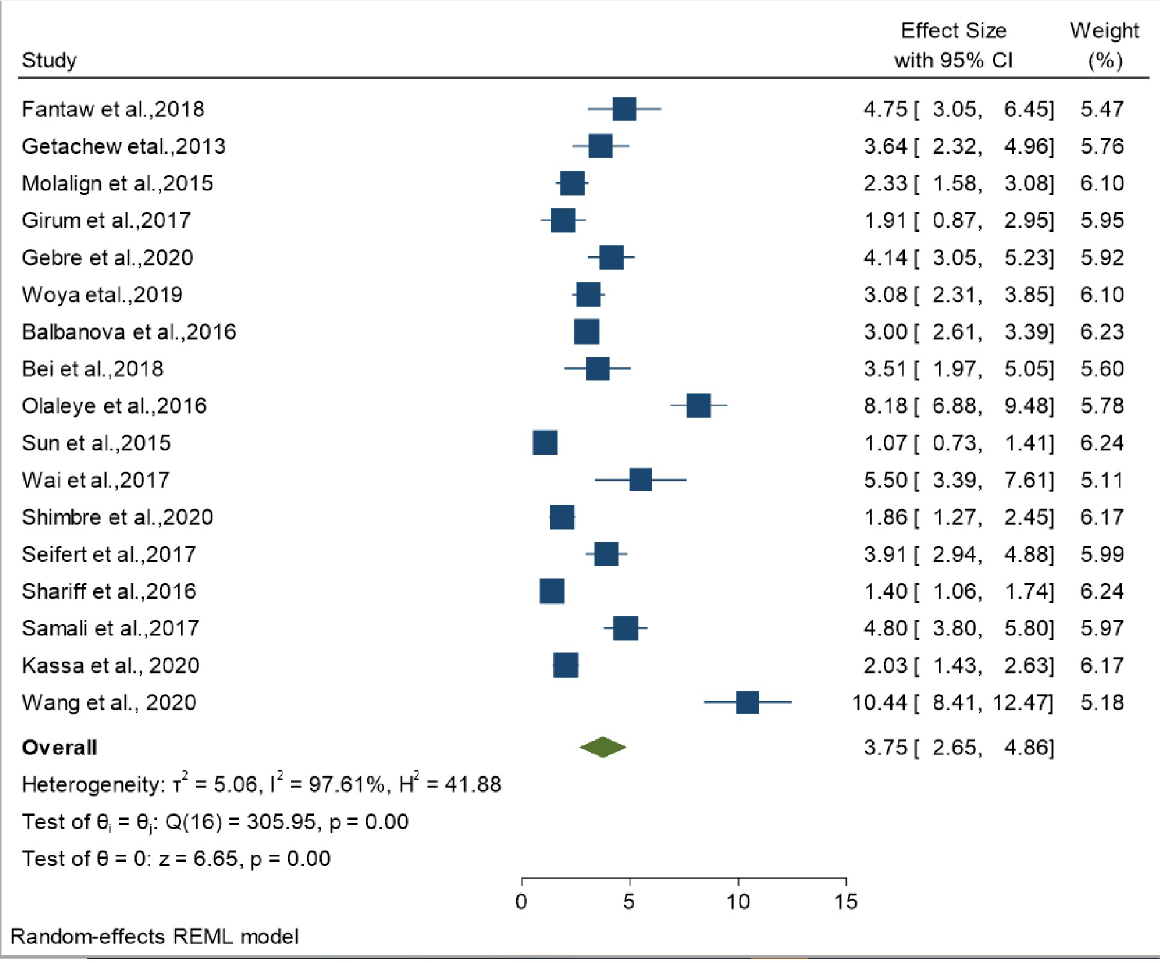
Fig 3. Forest plot for pooled incidence density rate of mortality in patients with drug-resistant tuberculosis.